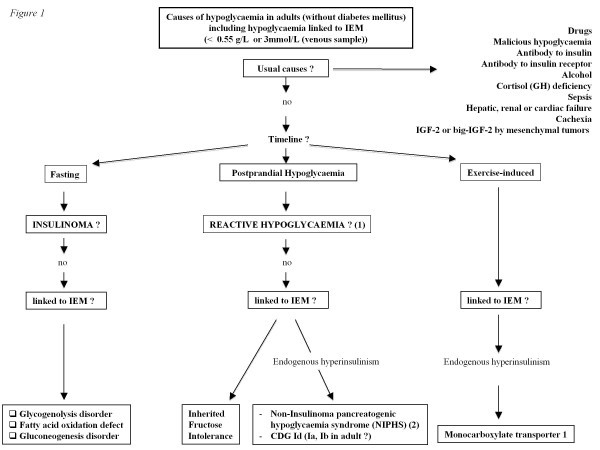
Causes of hypoglycaemia in adults (without diabetes mellitus) including hypoglycaemia linked to IEM. (1) Dysregulation of insulin secretion; Increase of insulin sensitivity; Dumping syndrome; Endogenous hyperinsulinism post surgery (gastric by-pass). (2) NIPHS (Non-Insulinoma pancreatogenic hypoglycaemia syndrome): Glucokinase activating mutation (and SUR1/Kir6.2, SCHAD, GDH mutations in adult ?).